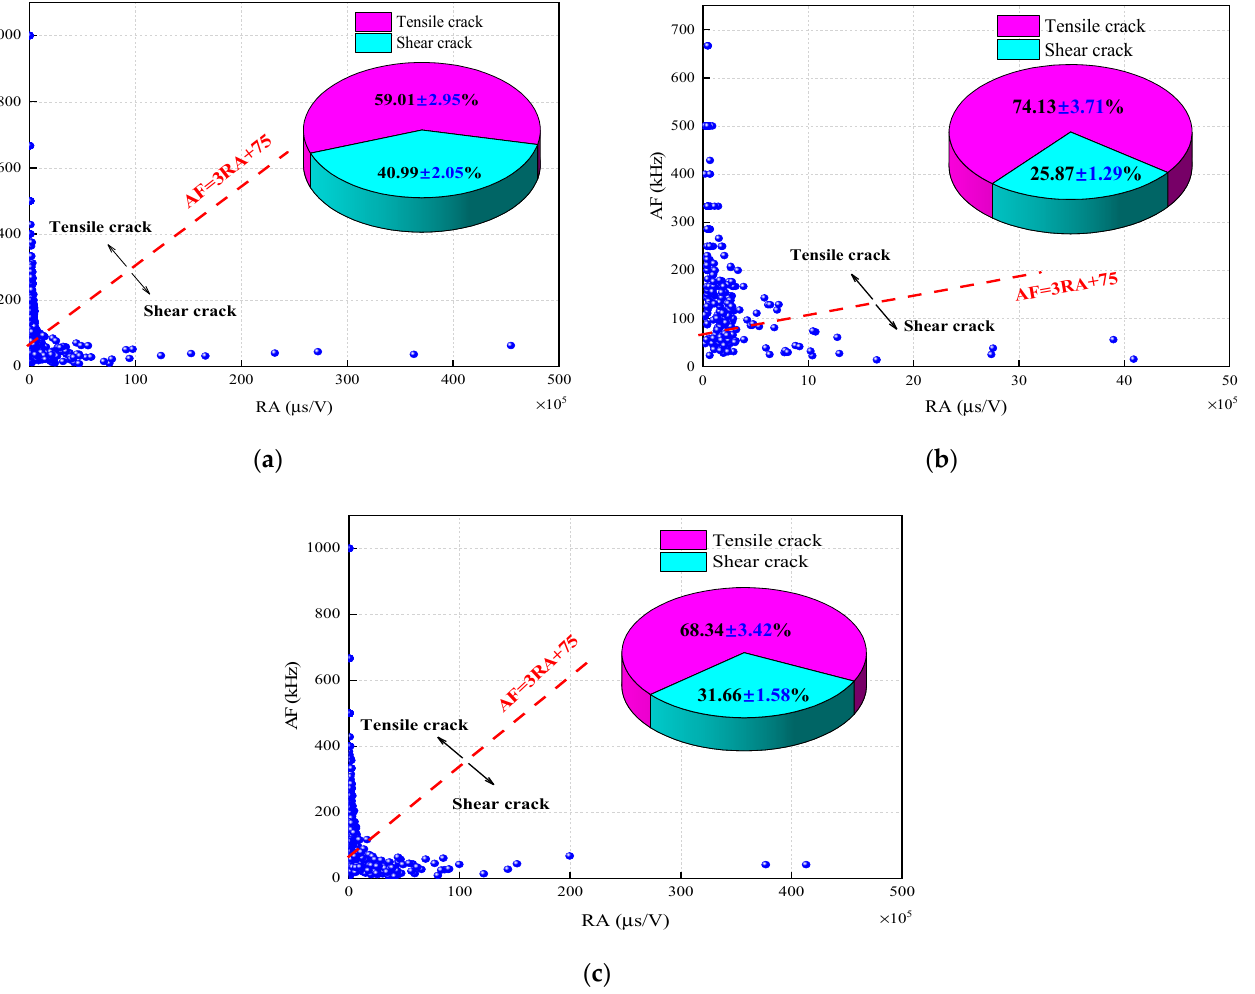
Figure 10. Microcrack classification for ANSCB specimen: ( a ) ANSCB − I; ( b ) ANSCB − II; ( c ) ANSCB − III.